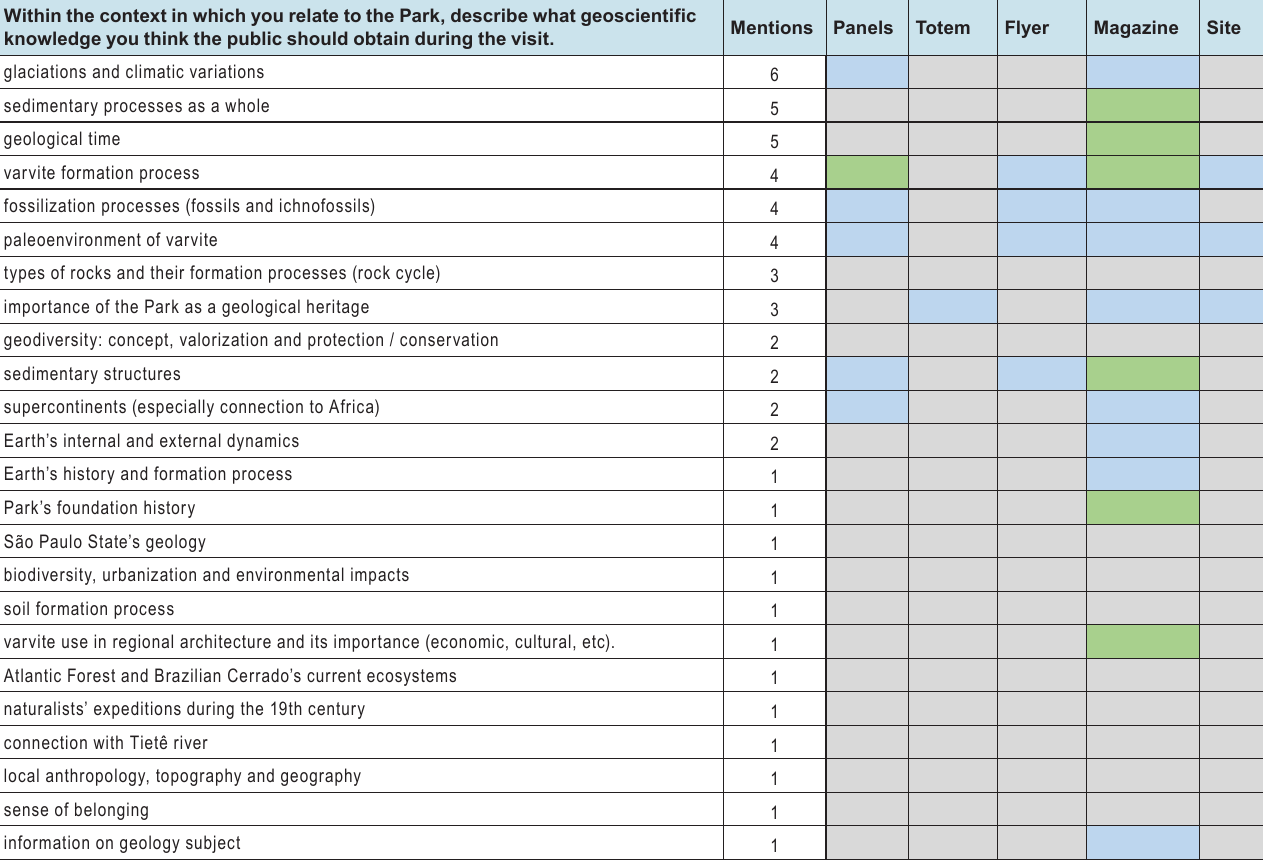
FIGURE 7. Different views from the Iceberg Viewpoint (Photos: Andrea Duarte Cañizares, 03/13/2020). TABLE 2. Stakeholders’ expectation and authors’ analysis about their approach in the different Parks’ communication channels (not observed: gray; partially observed/explained: blue; detailed explanation: